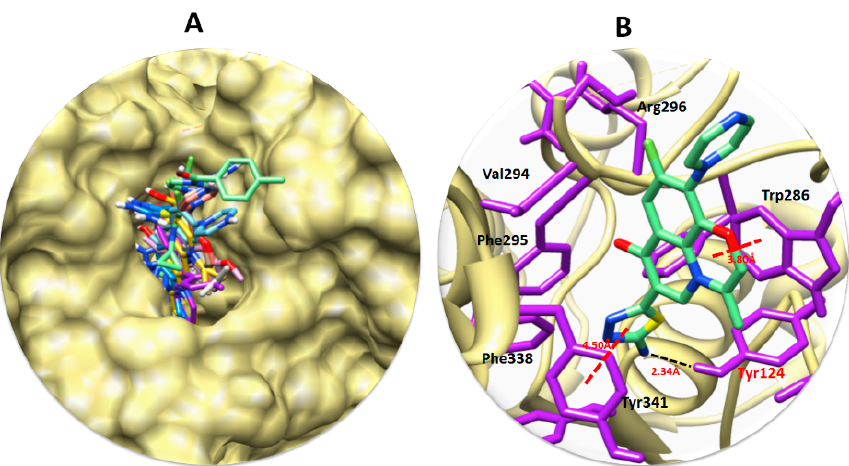
Figure 5. ( A ) Interactions of all the compounds within the active site of the target protein. ( B ) Docking interactions between 3f and the target protein. 3f is in light green, and the heteroatoms (oxygen, sulfur, and nitrogen) are shown in red, yellow, and blue, respectively. The protein is shown in khaki. The amino acids in the active site are highlighted in purple. The one hydrogen bond and two hydrophobic interactions are drawn in black and red lines,